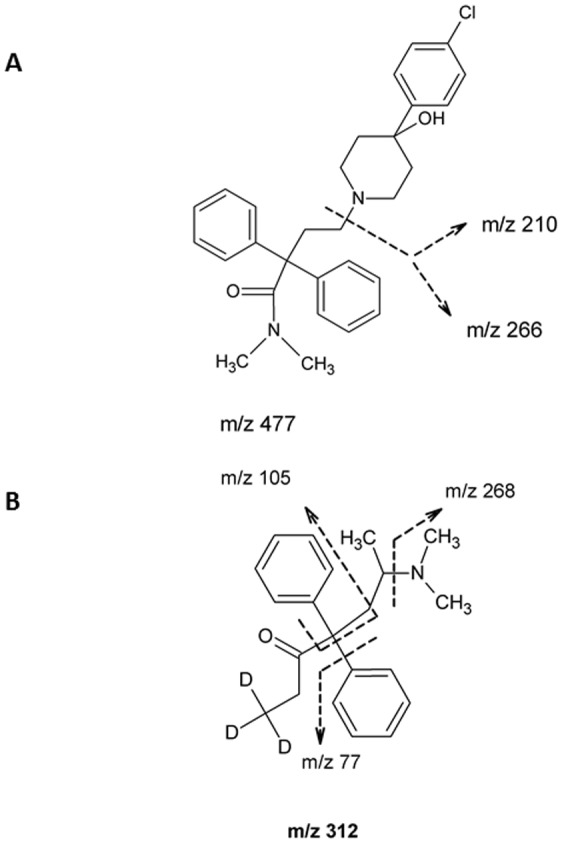
Product ion spectrum of loperamide (A) and methadone-d3 (B).